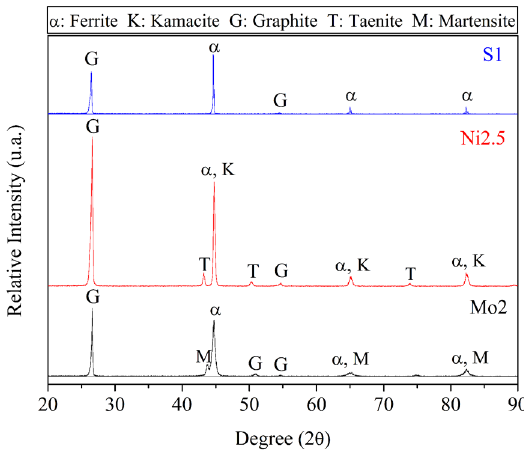
Figure 3. X-ray diffraction patterns for the samples. The numbers of JCPDS cards used to identify the phases were: 01-075-1621 (graphite), 01-087-072 (α-Fe) 00-0440-1293 (martensite) 00-037- 0474 (kamacite) and 00-047-1417 (taenite).